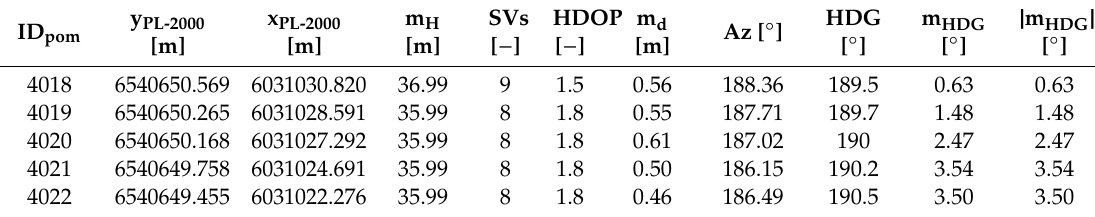
Table 4. Fragment of the output file containing calculation results.